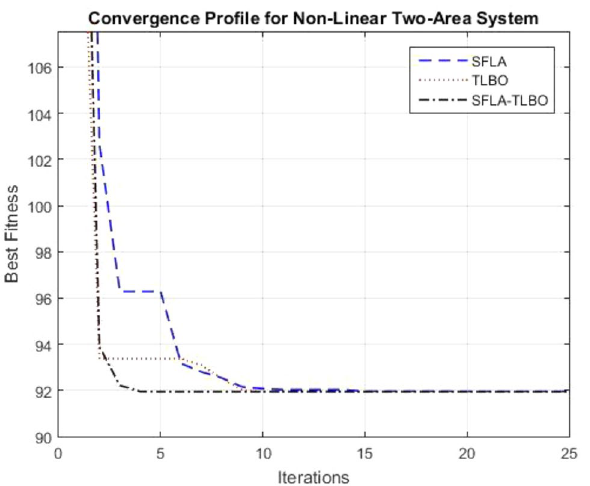
Fig. 11 Convergence profile for non-linear two-area system (mag- nified)